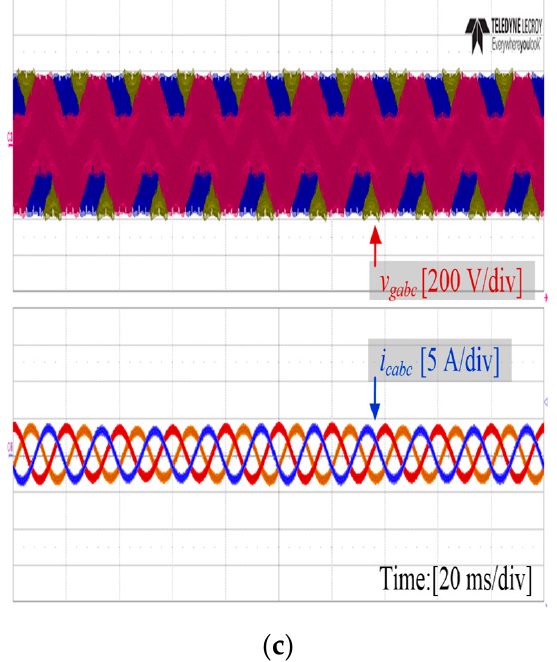
Figure 18. Experimental results of the DSTATCOMs without and with voltage droop: ( a ) overall view; ( b ) zoomed-in view without voltage droop; ( c ) zoomed-in view with a small voltage droop coefficient K vq = 1.2.